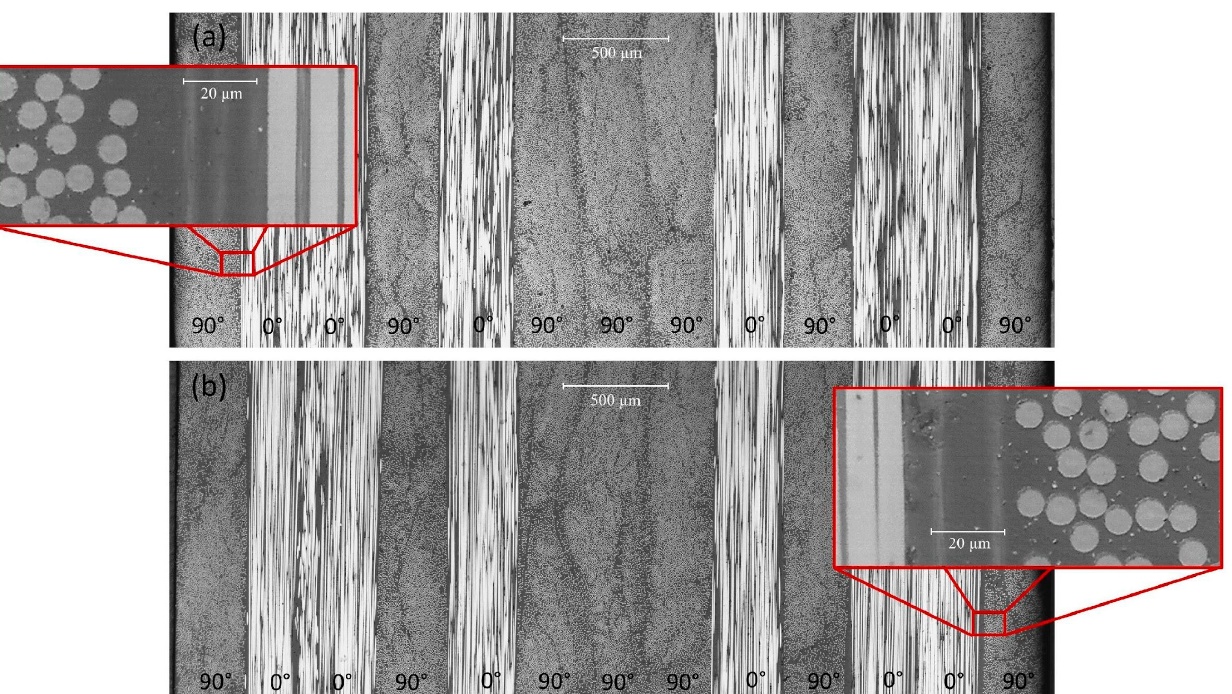
Figure 9. Micrograph picture (5 × ): ( a ) unaged material, ( b ) 45 days aged material. The whole stacking sequence is shown. 50 × details are shown for both ageing times.